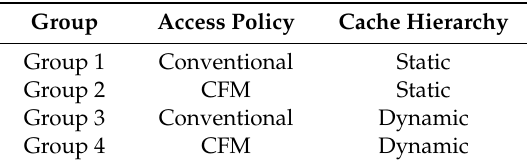
Table 3. Experimental group simulation parameters configuration.